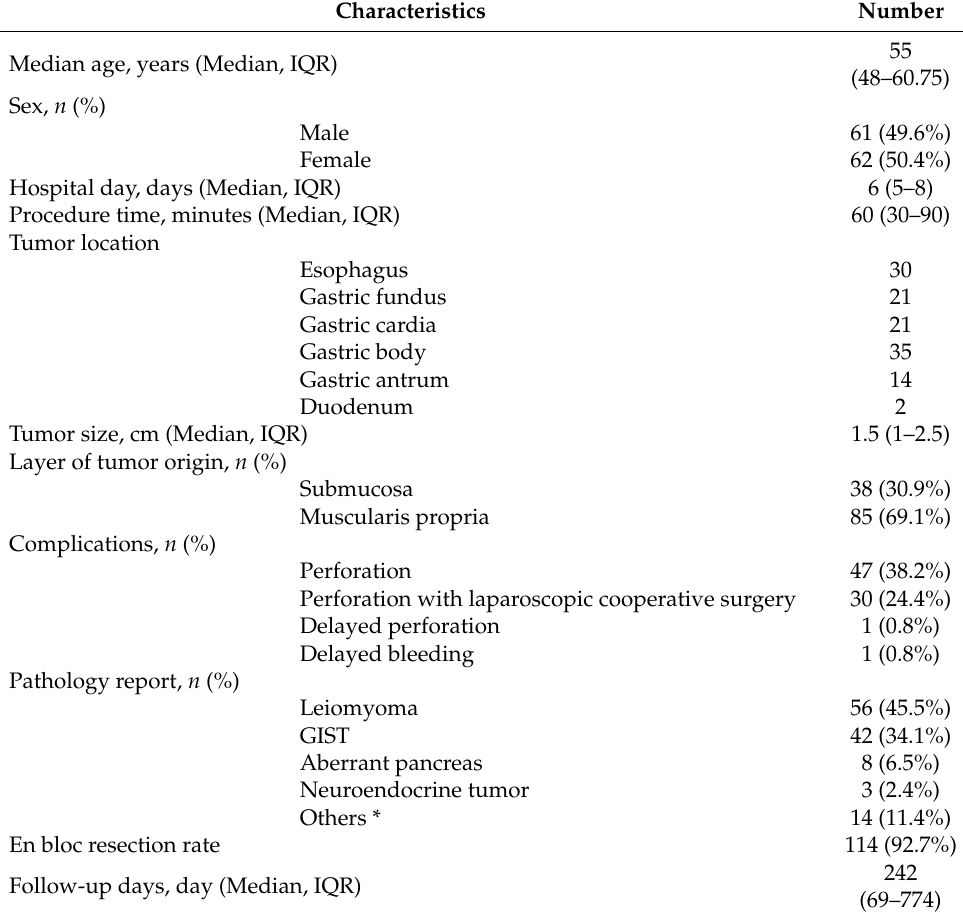
Table 1. Characteristics of patients and their subepithelial tumors.